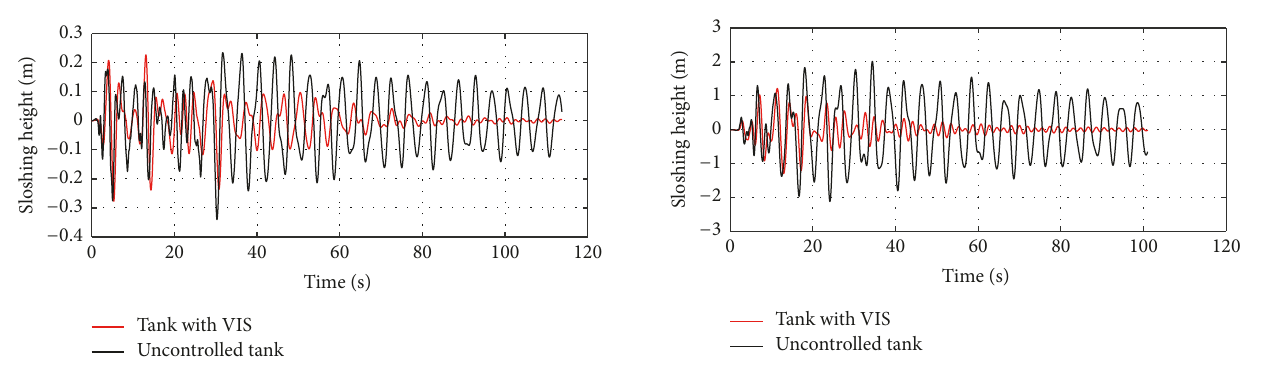
Figure 10: Dynamic responses of the sloshing height of the tank with the VIS under the excitation of the El Centro earthquake.